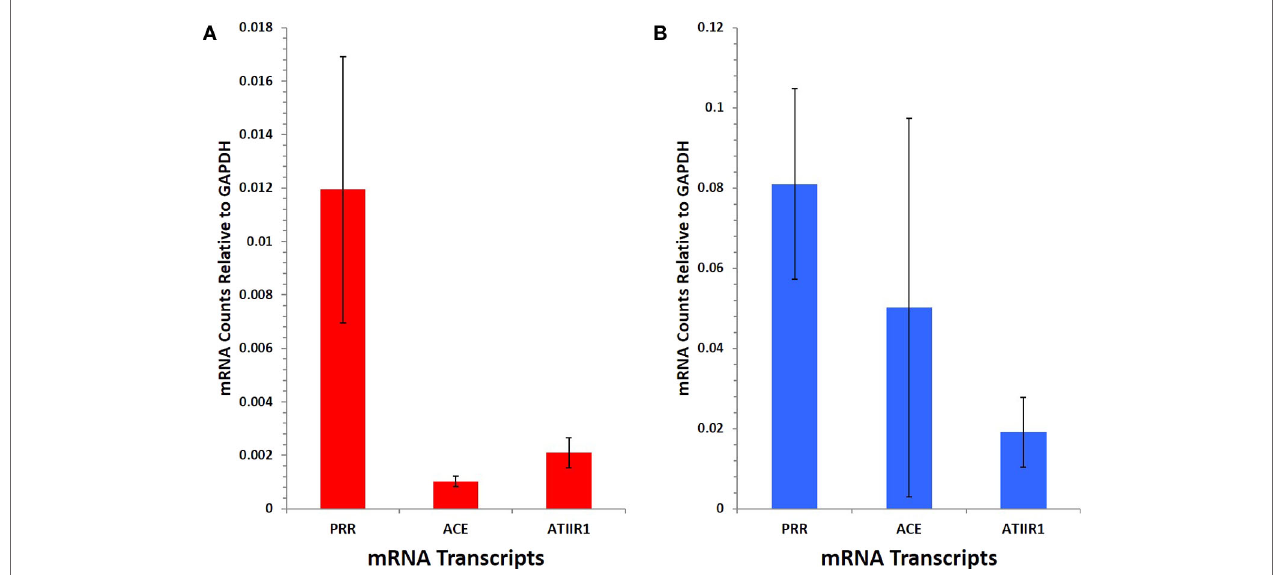
FigUre 5 | Prr, ace, and aTiir1 mrna levels in sc ( n = 3) (a) and iM ( n = 3) (B) VM tissues . Total mRNA was analyzed by NanoString nCounter Gene Expression assay with specific probes for PRR, ACE, ATIIR1 and ATIIR2 genes. Counts from ATIIR2 did not exceed those of the negative